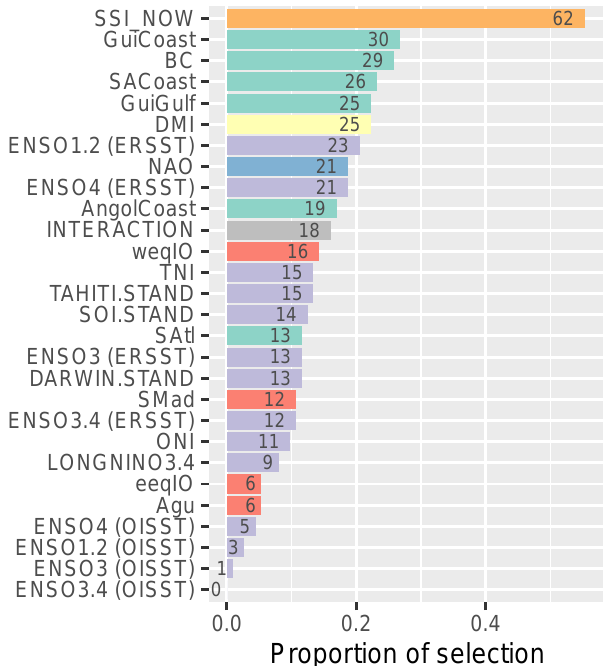
Figure 7. Predictor proportion of selection out of 112 (7 lead times for 16 stations) multiple linear models, with absolute num- ber as text. The presented predictors include customised and pre- defined teleconnection indices (for abbreviations, see Table 4), cur- rent streamflow (SSI_NOW) and interactions of predictors (no spe- cific interactions presented). Bars are coloured according to groups: customised Atlantic (green), DMI (yellow), ENSO (purple), cus- tomised Indian Ocean (red), NAO (blue), current streamflow (or- ange), interactions of selected predictors (grey).